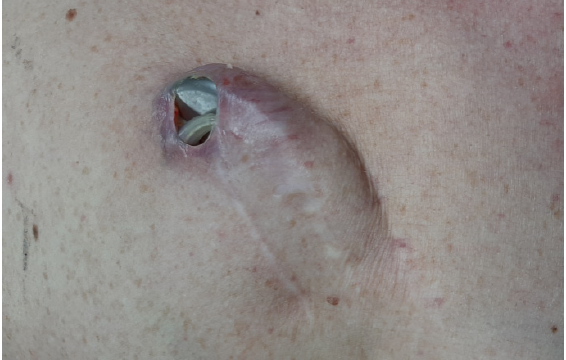
Figure 1. The aspect of the pocket erosion with the extravasation of the device and the lead, at the moment of admission to the hospital.